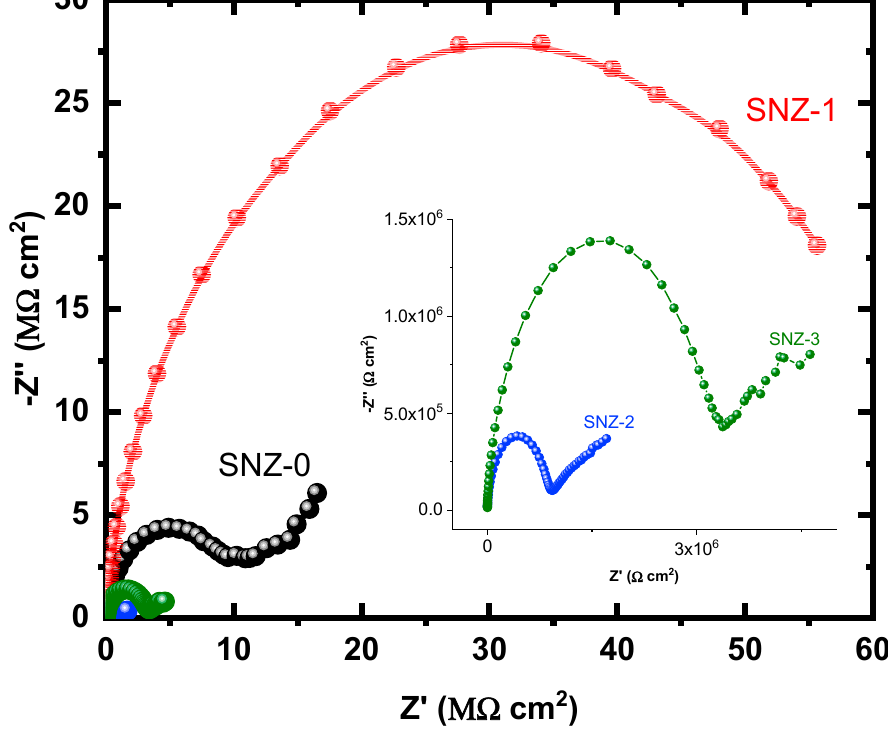
Figure 9. Nyquist plots of the coatings after 25 days’ immersion in a 3.5% NaCl solution.